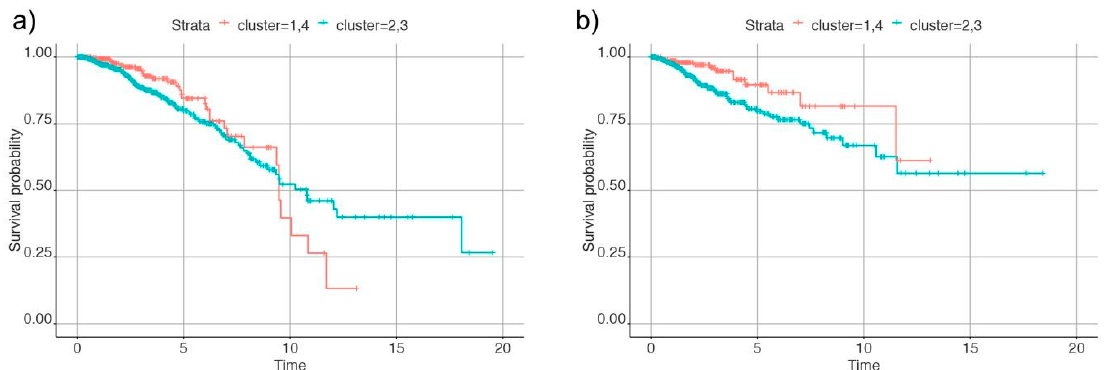
Figure 4. Plots of Kaplan-Meier estimates for ( a ) overall survival and ( b ) recurrence of cancer in the individuals. Clusters 1 and 4 are denoted by the red line and clusters 2 and 3 by the blue line.